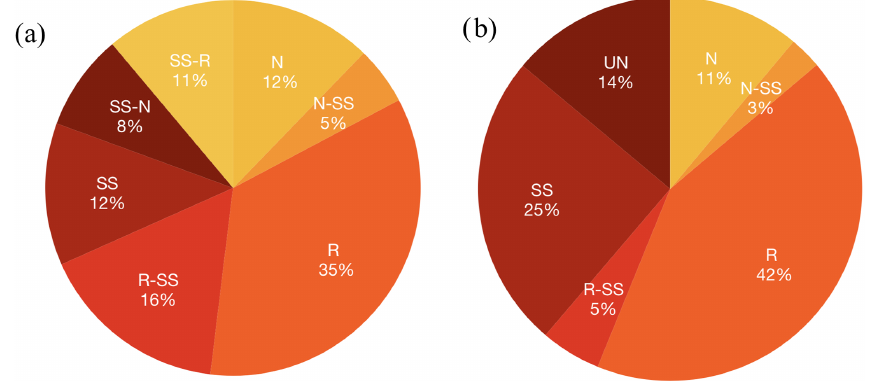
Figure 6. (a) Classification of the focal mechanism according to Álvarez-Gómez (2019) and (b) Zoback (1992). N: normal; N-SS: normal – strike-slip; SS-N: strike-slip – normal; SS: strike-slip; SS-R: strike-slip – reverse; R-SS: reverse – strike-slip; R: reverse; UN: unknown.